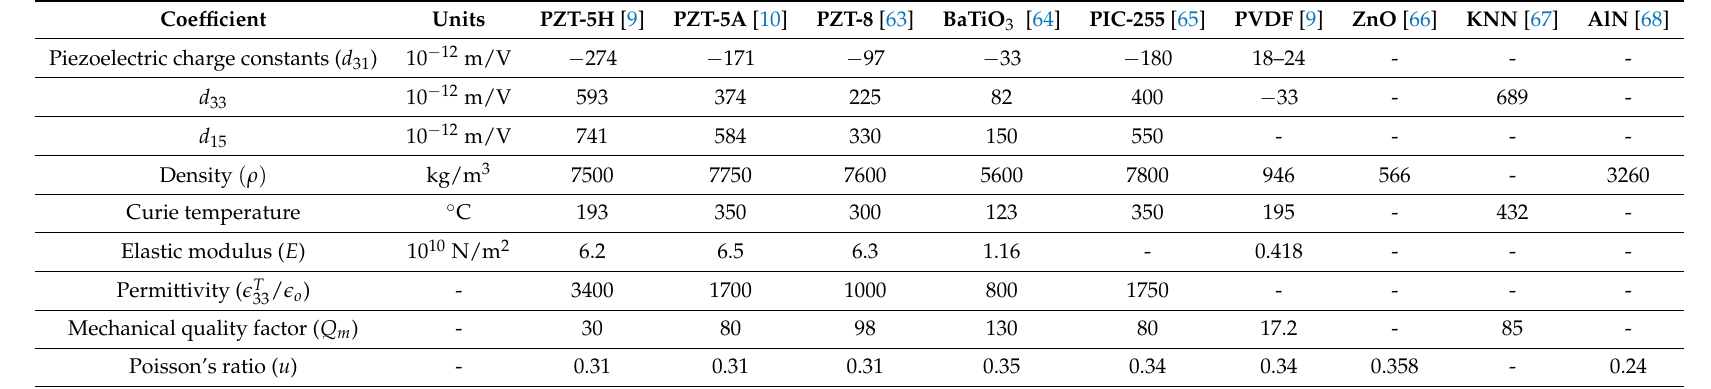
Table 1. Piezoelectric material